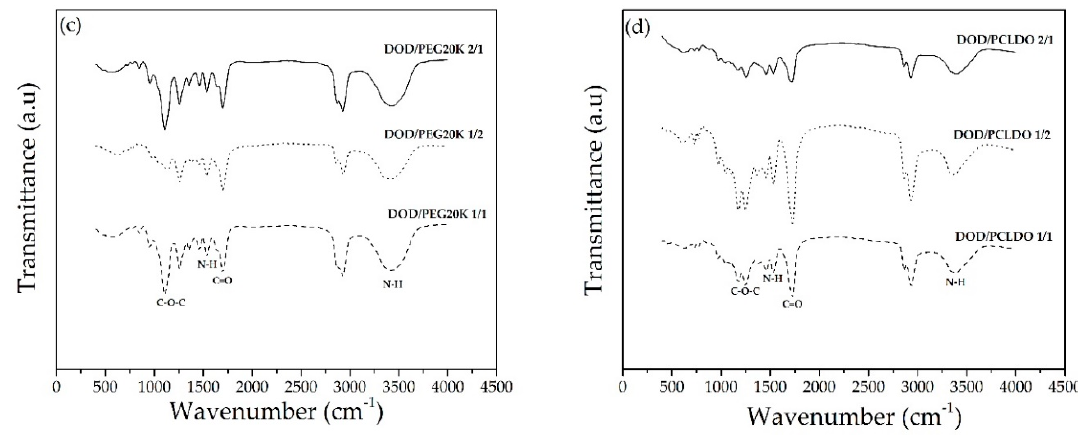
Figure 8. FTIR spectra of ( a ) PU-DOD/PEG200, ( b ) PU-DOD/PEG2K, ( c ) PU-DOD/PEG20K, and ( d ) PU-DOD/PCLDO.